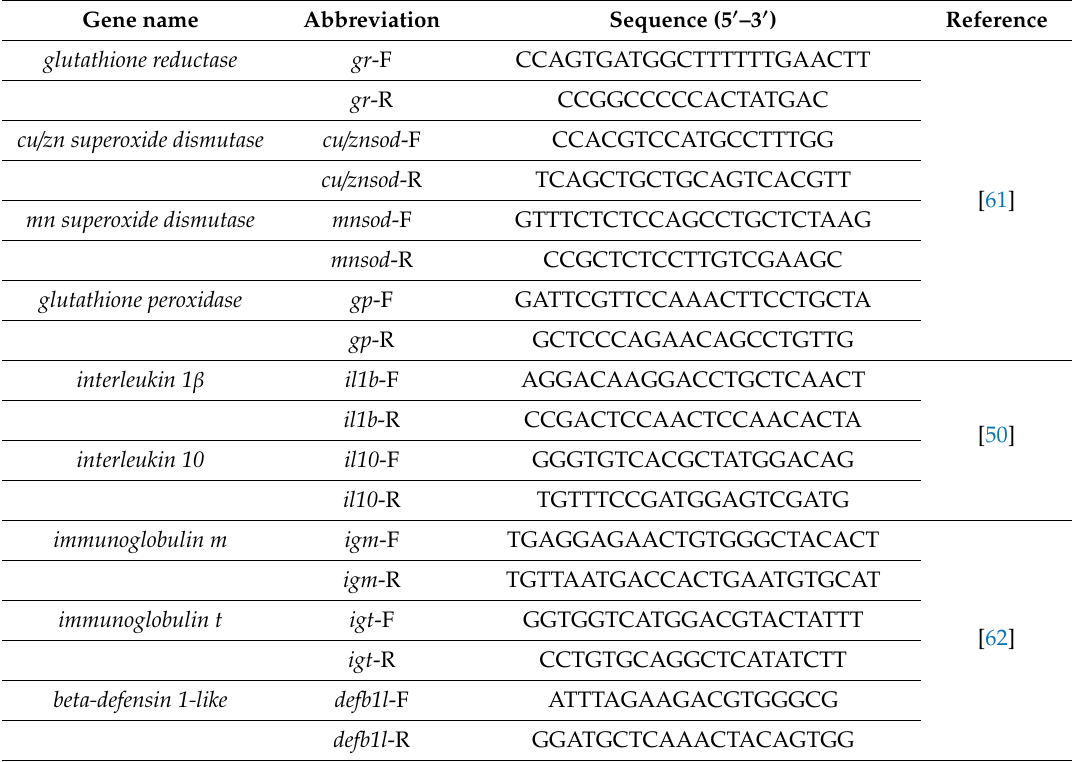
Table 2. Primers used in the